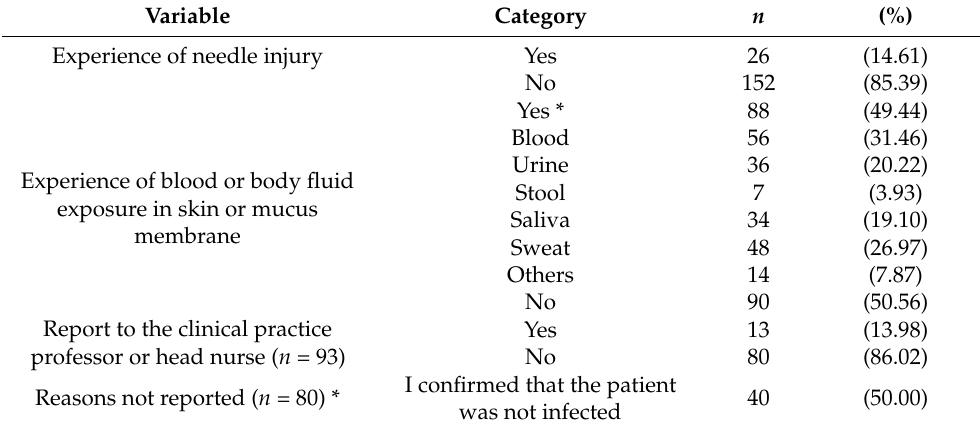
Table 2. Experience of occupational exposure during clinical practice ( n =